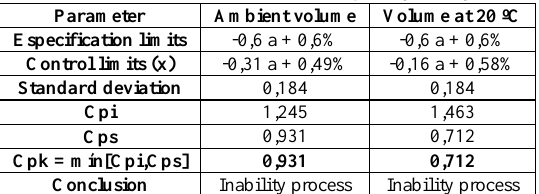
Table 3: Control limits and capacity study.